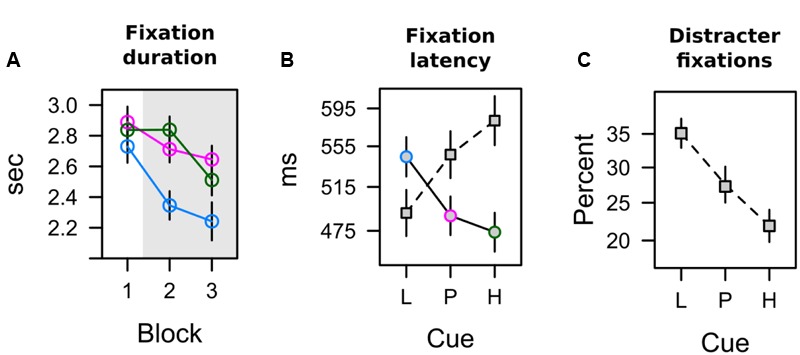
Overt attention in the learning task (A) Duration of fixations on cues with low [blue], partial [red], and high [green] shock expectancy. (B) Latency of the first fixation on the circular color cue [solid line] and the diamond distracter [dashed line]. (C) The percentage of distracter fixations depends upon how strongly the color cue is associated with shock.